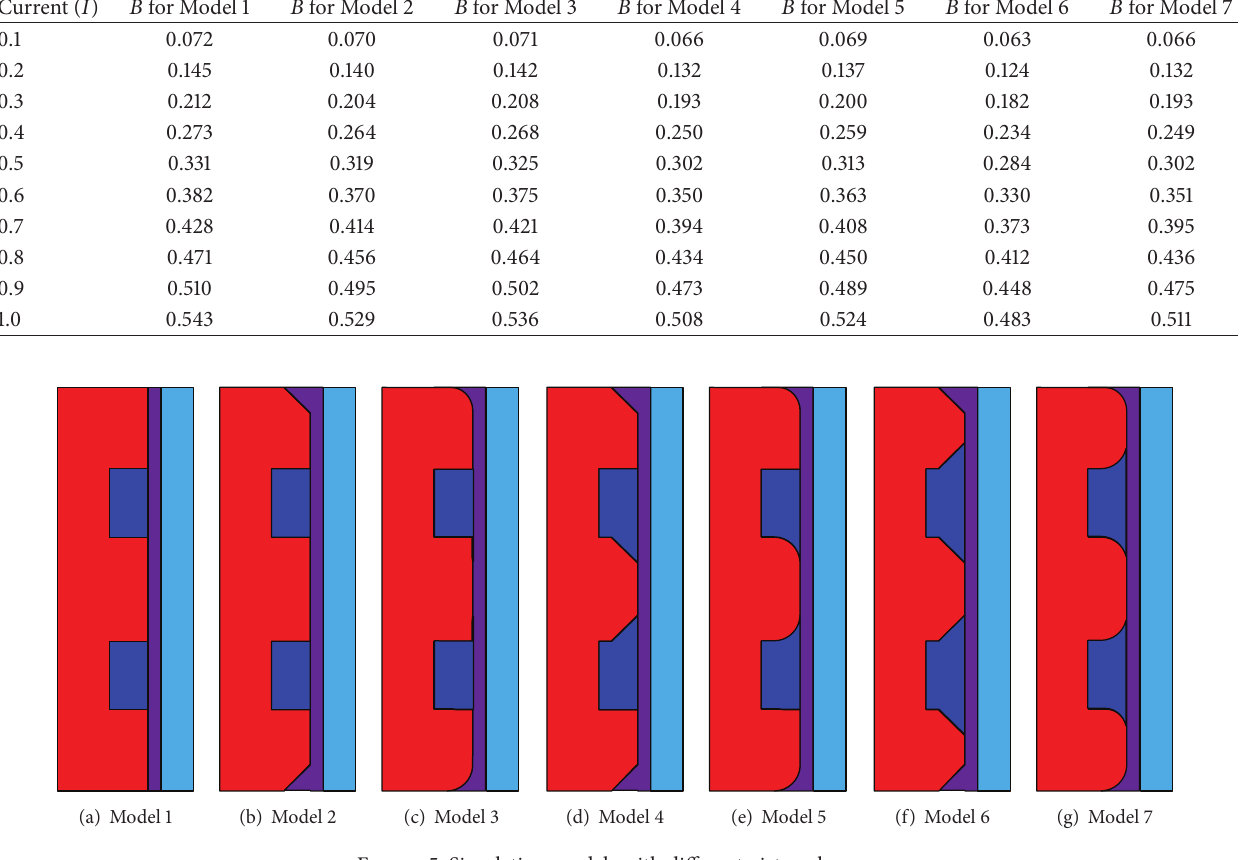
Figure 5: Simulation models with different piston shapes.